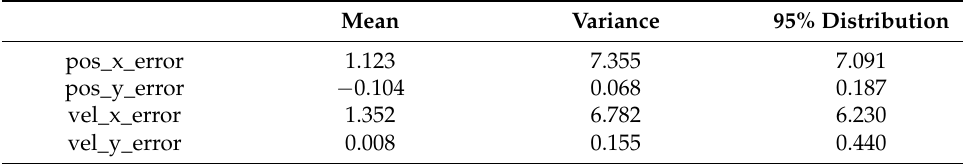
Figure 18. Error frequency distribution. For the autonomous system to have a comprehensive and accurate understanding of the surrounding dynamic environment, it is necessary to integrate more types of sensors to compensate for each other. In the future, we will integrate the Radar sensor into the tracking system to improve its performance of the tracking system. Aditionally, the ro- bustness of the tracking system under different light and weather conditions is another big problem needed to address in future work. 9. Conclusions This paper designs a robust tracking system based on a mono camera. According to the characteristics of the mono camera, a YOLO-based detector is used to give out the bounding boxes and a vanishing point-based depth estimator is used to estimate the dis- tance to compensate for the lost depth information caused by projecting from the 3D Car- tesian coordinate to the 2D image plane. To track the vehicle on the highway, a constant velocity model is used in this paper and the Extended Kalman filter is applied to deal with the mono camera nonlinear measurement problem. Nearest neighbor with a gating trick